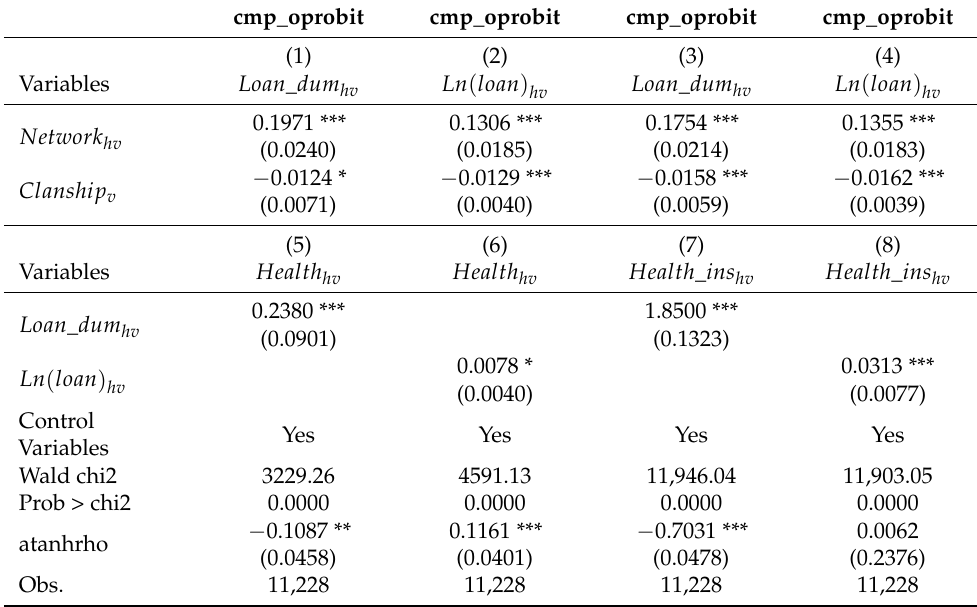
Table 4. Effects of social networks and microcredit on health.